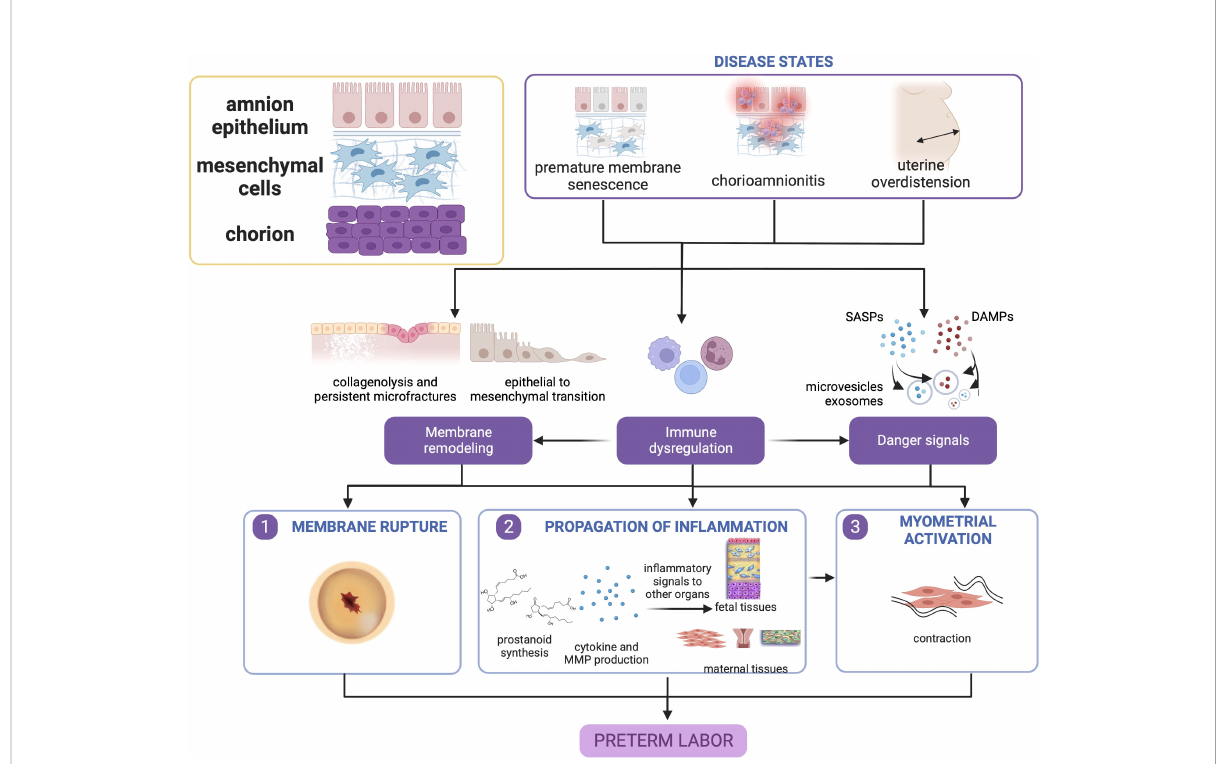
FIGURE 2 Disease states in the fetal membranes contribute to preterm birth. Premature membrane senescence, chorioamnionitis, and uterine overdistension can all lead to dysfunctional membrane remodeling, generation of danger signals (senescence-associated secretory phenotype [SASP], and damage associate molecular pattern markers [DAMPs], and chemotaxis and immune cell activation. The localized presence of danger signals provides greater contributions toward untimely membrane rupture, while immune cell activation in the presence of danger signals may cause myometrial activation. This fi gure was created with